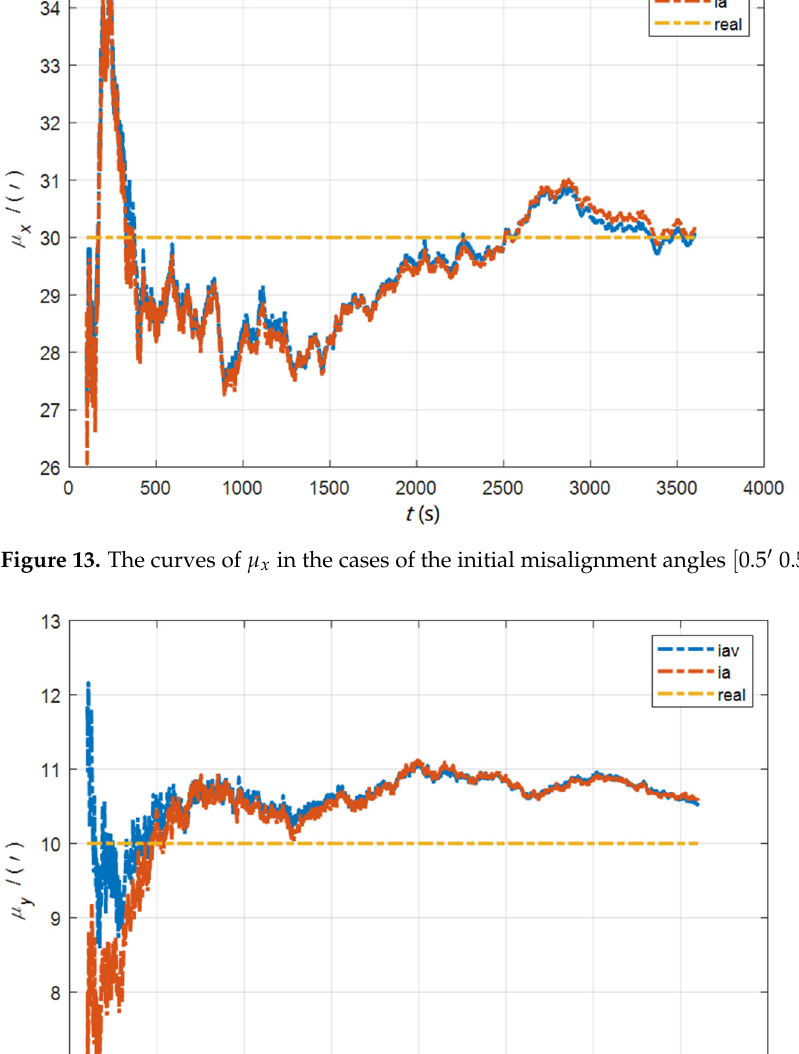
μ μ Figure 14. The curves of in the cases of the initial misalignment angles Figure 14. The curves of in the cases of the initial misalignment angles y y In the cases of the initial misalignment angles [ 0.5 (cid:48) 0.5 (cid:48) 10 (cid:48) ] T , the error curves of the dynamic deflection deformation angle γ are shown in Figures